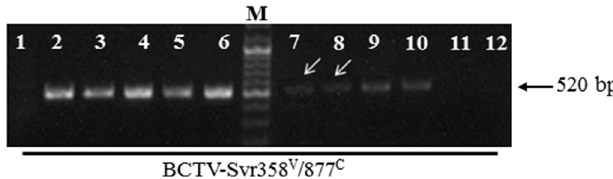
Figure 3. Agarose gel electrophoresis analysis of immunocapture PCR products using a BCTV antibody and specific BCTV-Svr358 V /877 C primer pair. Lane 1, extract of leaf tissue of healthy plants of local cultivar as negative control; lanes 2–6, extracts of leaf tissue of naturally infected plants of local cultivar; lanes 7 and 8, extracts of seeds of naturally infected plants of local cultivar; lanes 9 and 10 extracts of seeds of BCTV-Svr-agroinoculated plants of PCSP cultivar, lanes 11 and 12 extract of seeds developed from healthy plants of PCSP cultivar. M = Marker (DNA ladder mix, Fermentas).